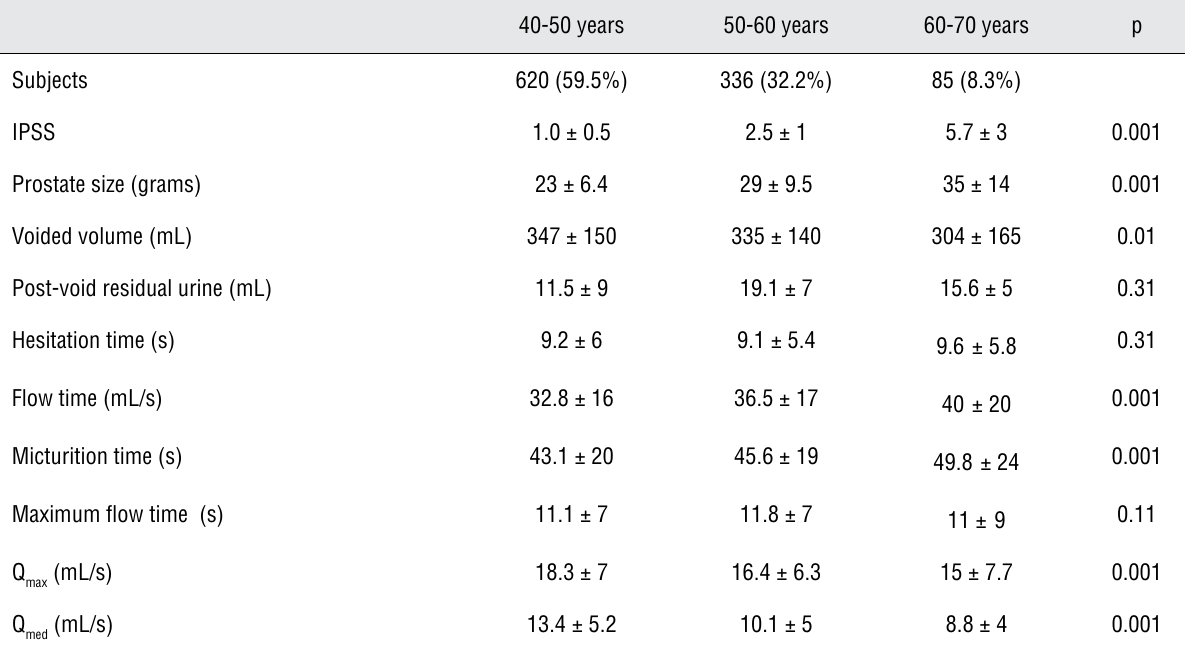
Table 2 - IPSS, prostate size and uroflow data on three different aging